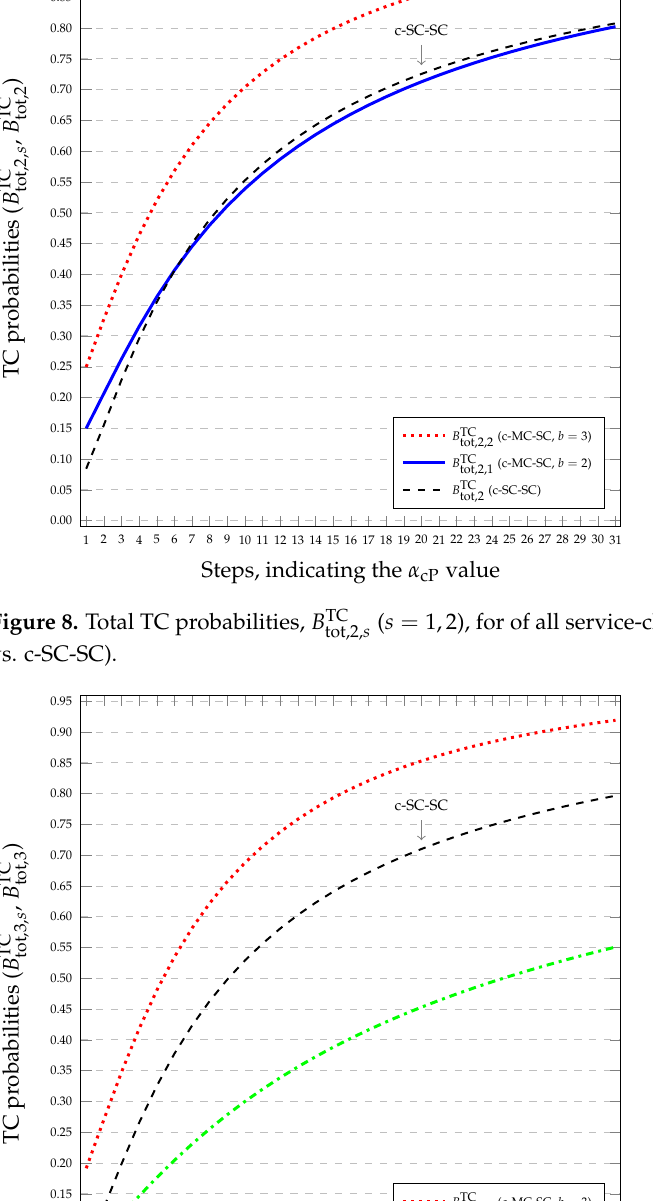
Figure 9. Total TC probabilities, B TC